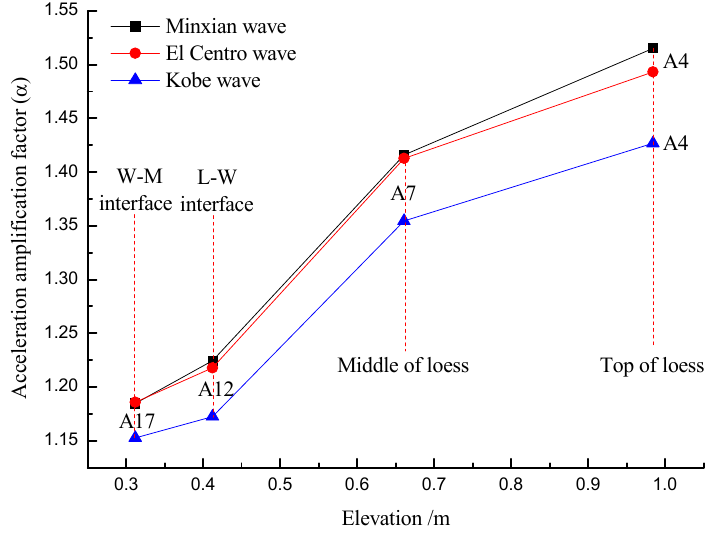
Figure 8. Variation in AAFs with elevation along the vertical section with three types of earthquake waves with an input PGA of a = 0.1 g.